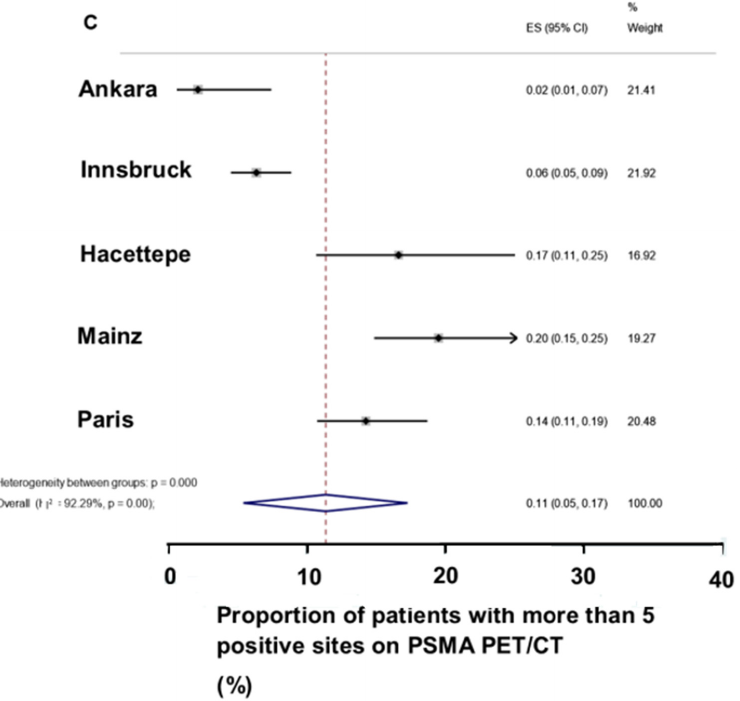
Figure 3. The Forest plot of the patients with PSA-only relapse in the five cohorts. ( A ) a third of the patients had a negative restaging PSMA PET/CT, ( B ) more than half of the patients had one to five positive sites, ( C ) a tenth of the patients had more than five positive sites.